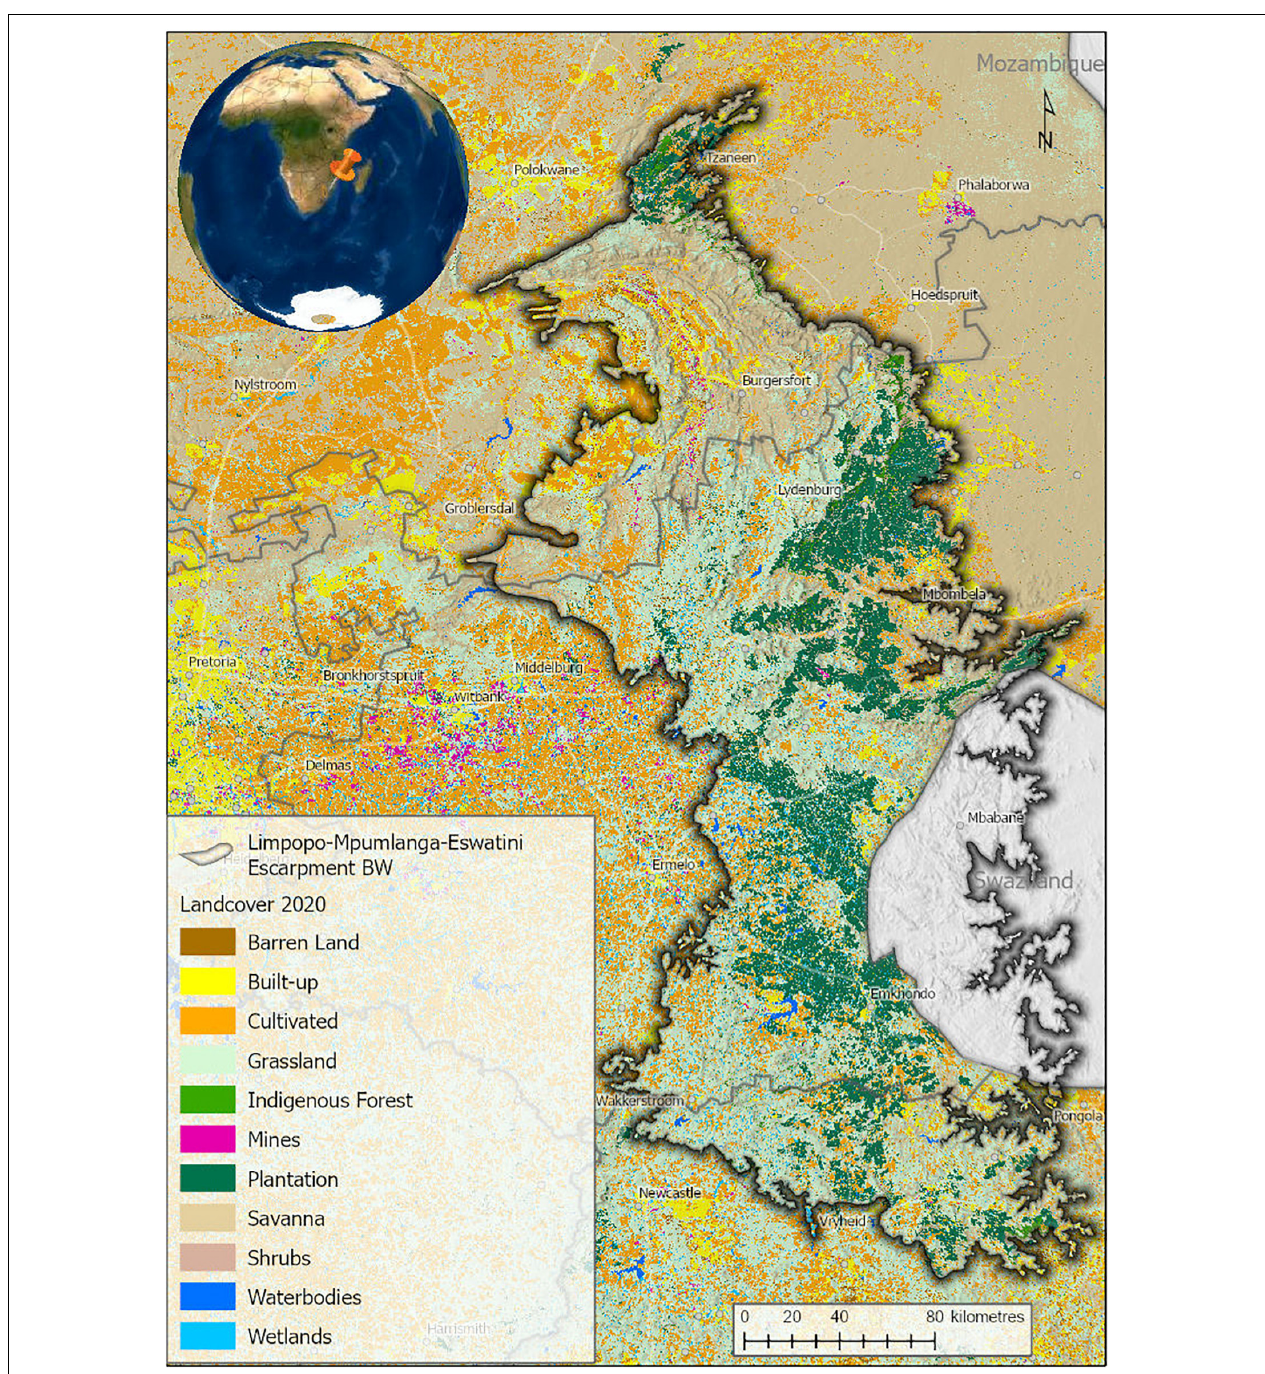
FIGURE 2 | Land-cover in the Limpopo–Mpumalanga–Eswatini Escarpment (LMEE) in 2020. Land-cover generated from Sentinel 2 satellite imagery for South Africa (Geoterraimage, 2021).